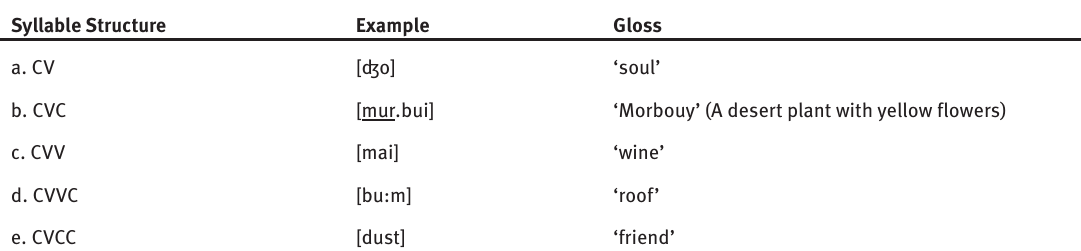
Table 4 : Syllable structure in Sabzevari